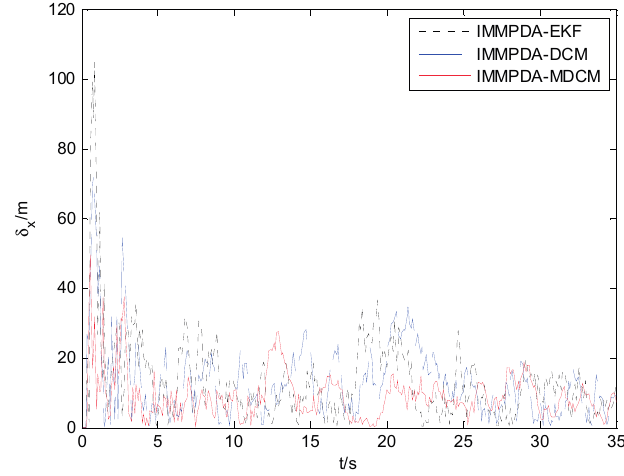
Figure 6. The comparison of position error in x direction.